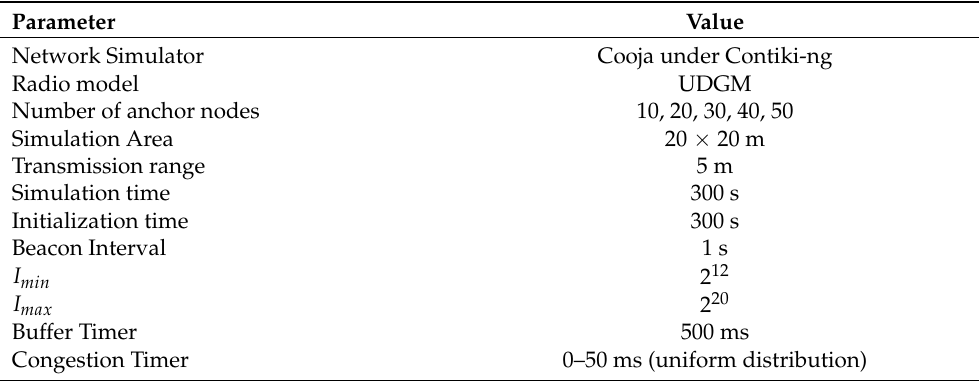
Table 3. The parameters used in the